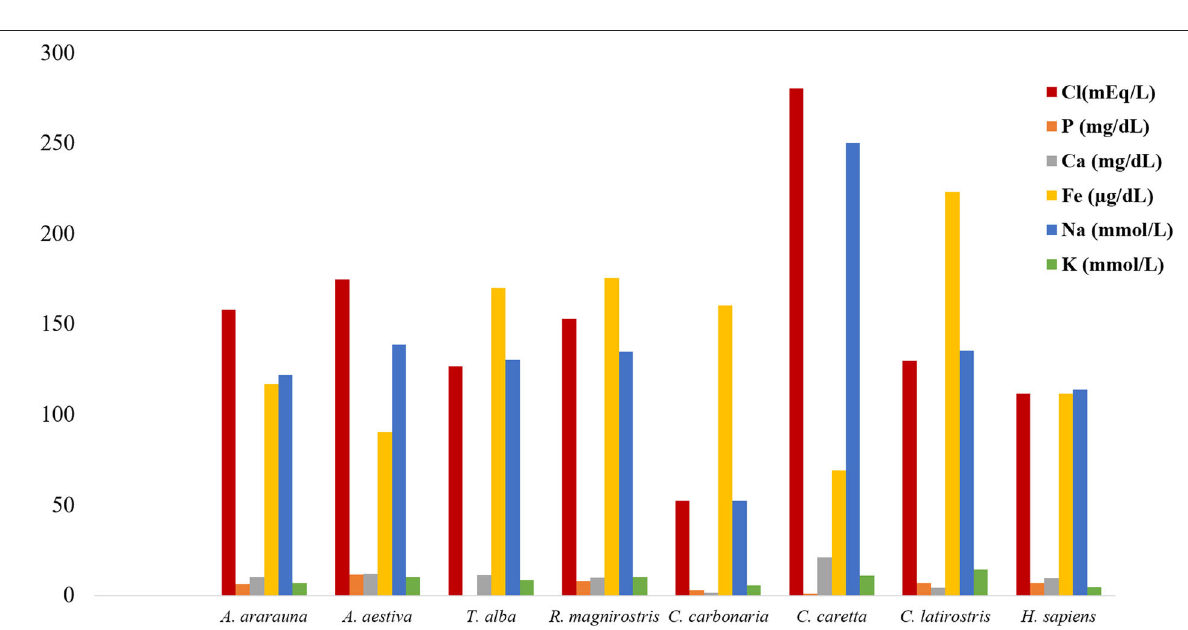
Frontiers in Veterinary Science |